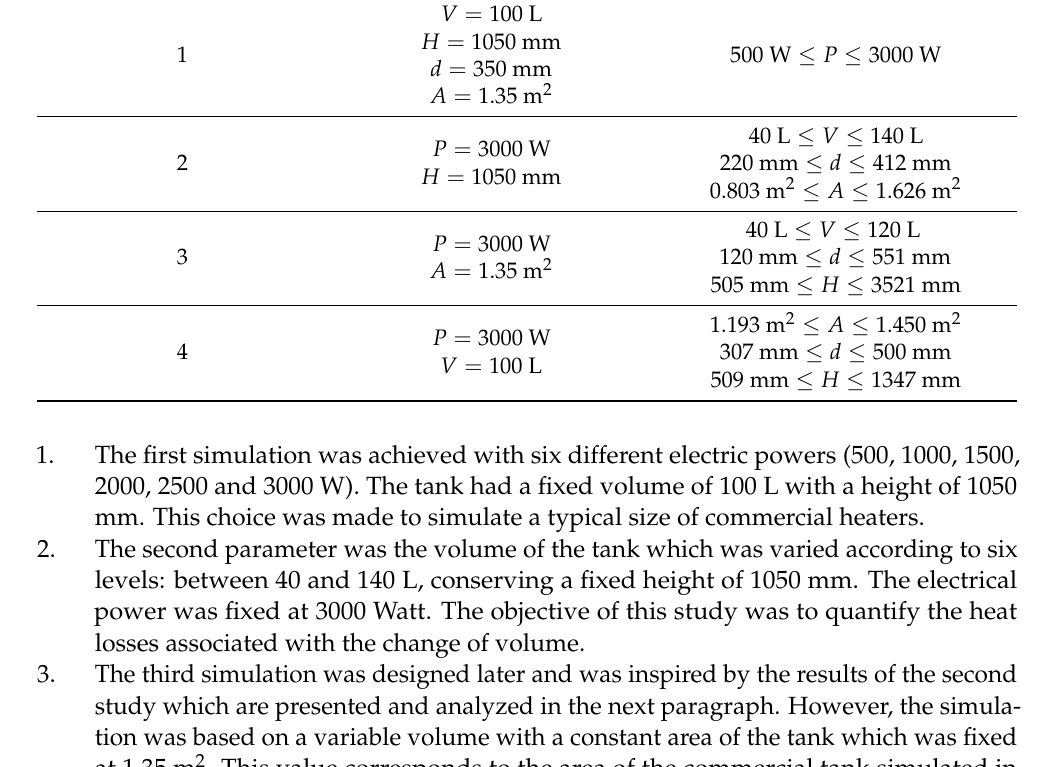
Table 1: the electric power, the volume and the external area of the tank. For all simulations, the initial temperature of water ( T wi ) and the ambient temperature ( T a ) were both fixed at 20 ◦ C. Table 1. Parameters of the study.